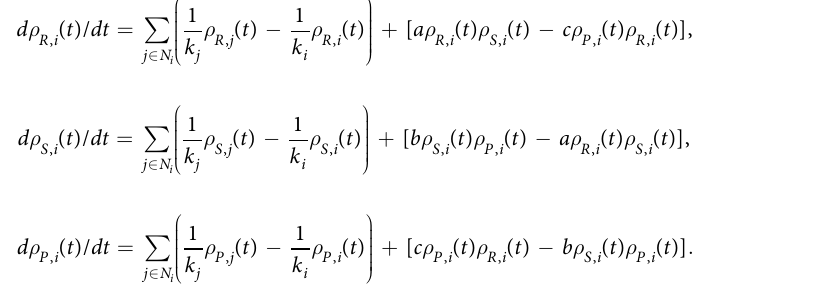
where k i is the degree of node i and N i represents the nearest neighbors of node i (sum over all paths) 50 . In equa- tion (5), the terms on the right-hand side indicate the amount of incoming and outgoing individuals. According to mean-field theory, the densities of R, S, and P walkers in node i are described by d